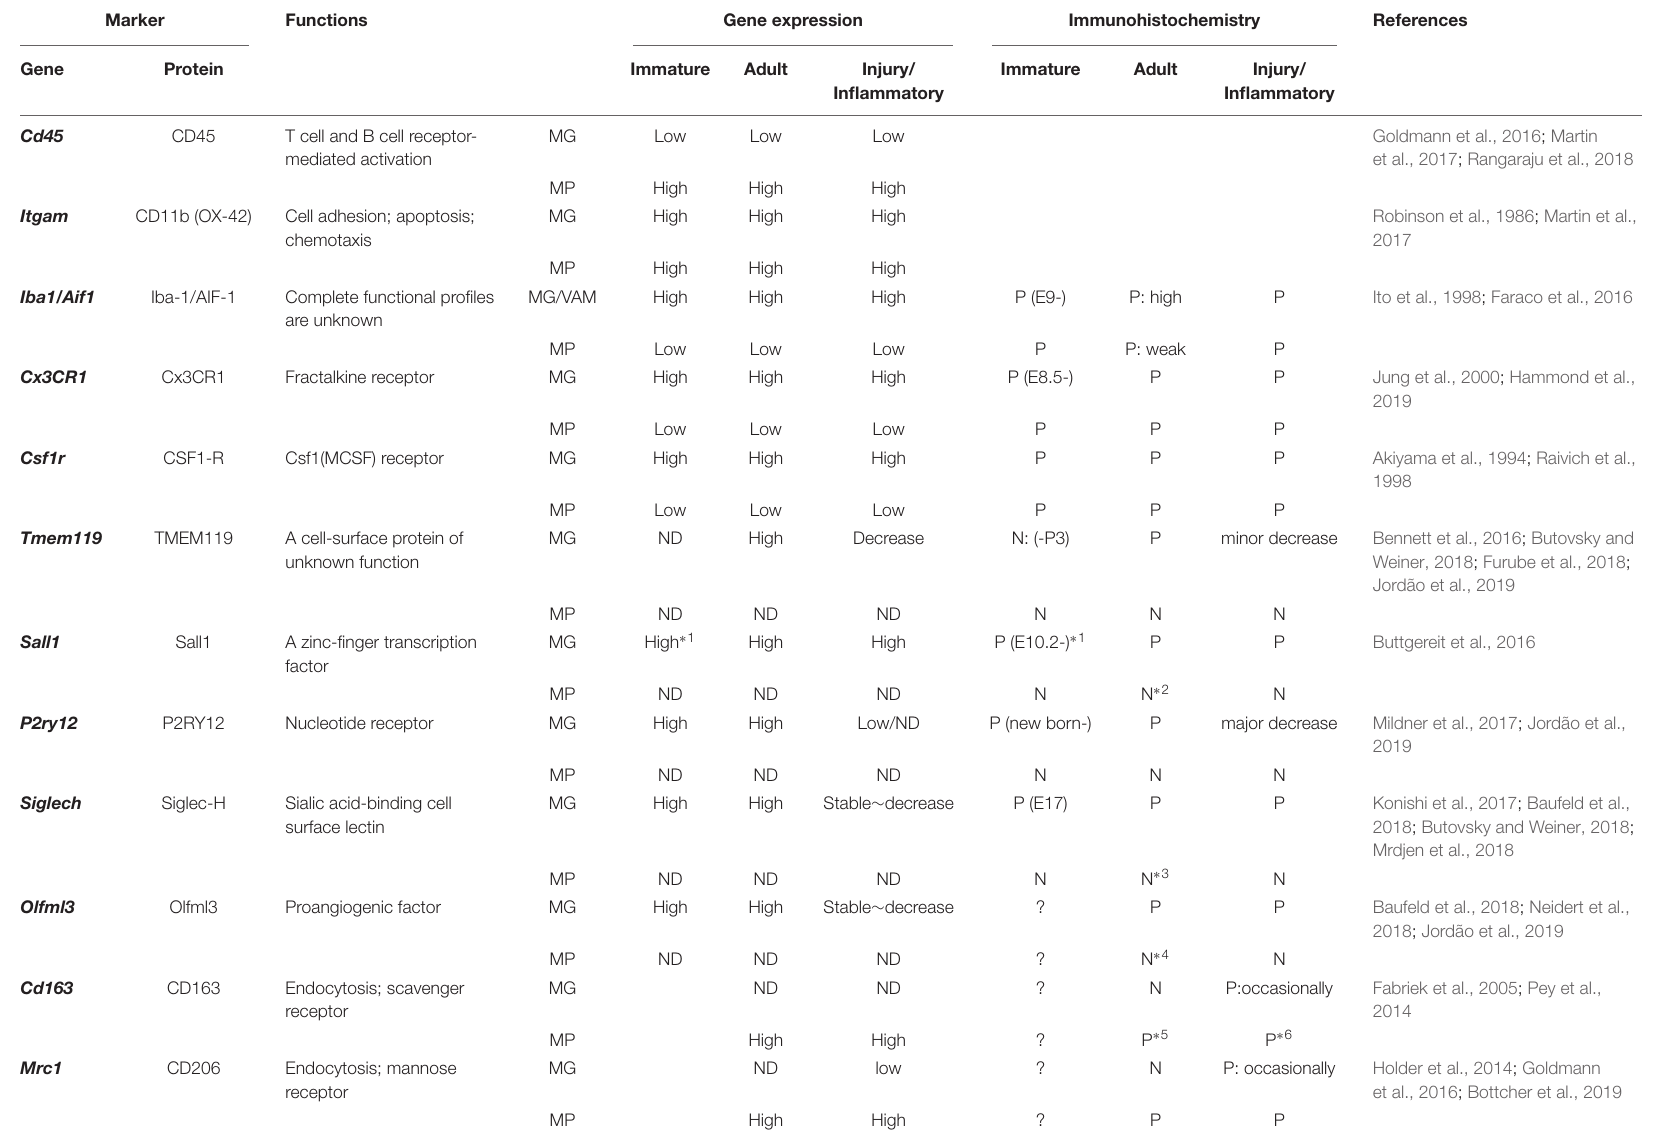
TABLE 1 | Differentiation markers for microglia (MG), including vessel-associated microglia (VAM), and CNS macrophages (MP), including perivascular macrophages (PVMs).